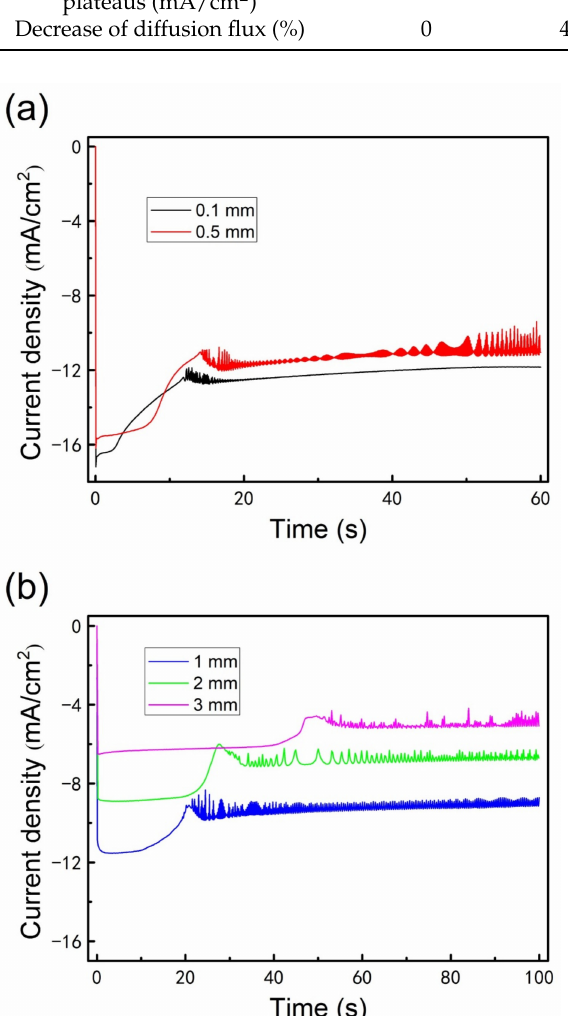
Figure 4. Chronoamperometry curves recorded on Cu plate with different thicknesses of insulation ring (inner diameter was 6 mm) during the electrodeposition of Al nanowires in AlCl 3 –BMPC (2:1 molar ratio) ionic liquid at − 1.2 V/25 ◦ C under the restricted diffusion condition: ( a ) 0.1 and 0.5 mm; ( b ) 1, 2 and 3 mm. Deposition time was ( a ) 60 s and ( b ) 100